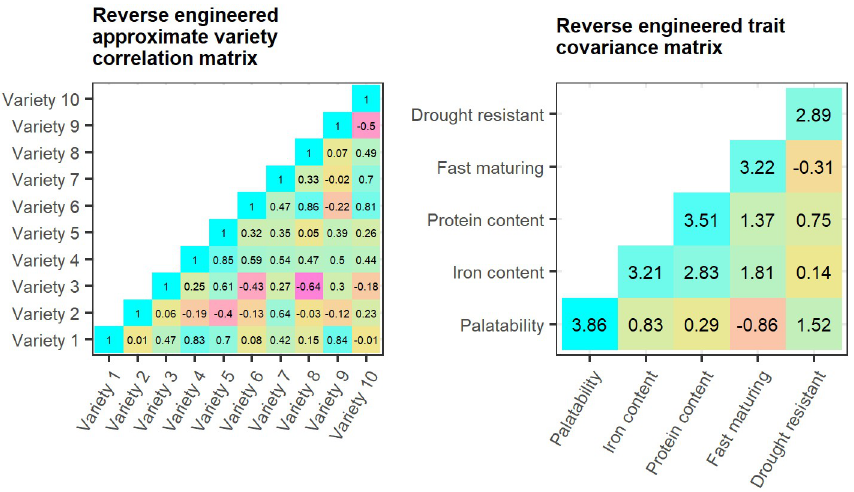
Fig 10. (Left) Approximate variety correlation matrix and (Right) trait covariance matrix reverse engineered from the hypothetical crowdsourced trait-variety